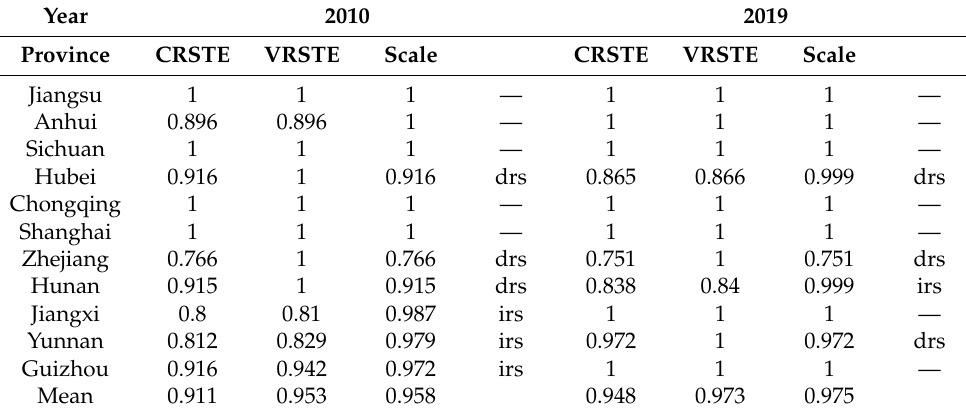
Table 1. APE in 2010 and 2019.